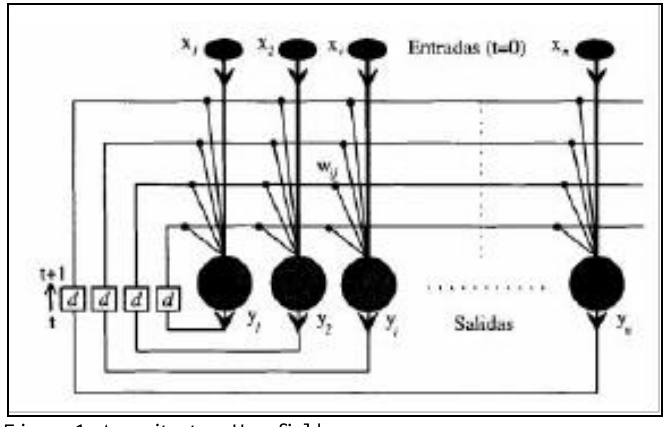
Figura 1: Arquitectura